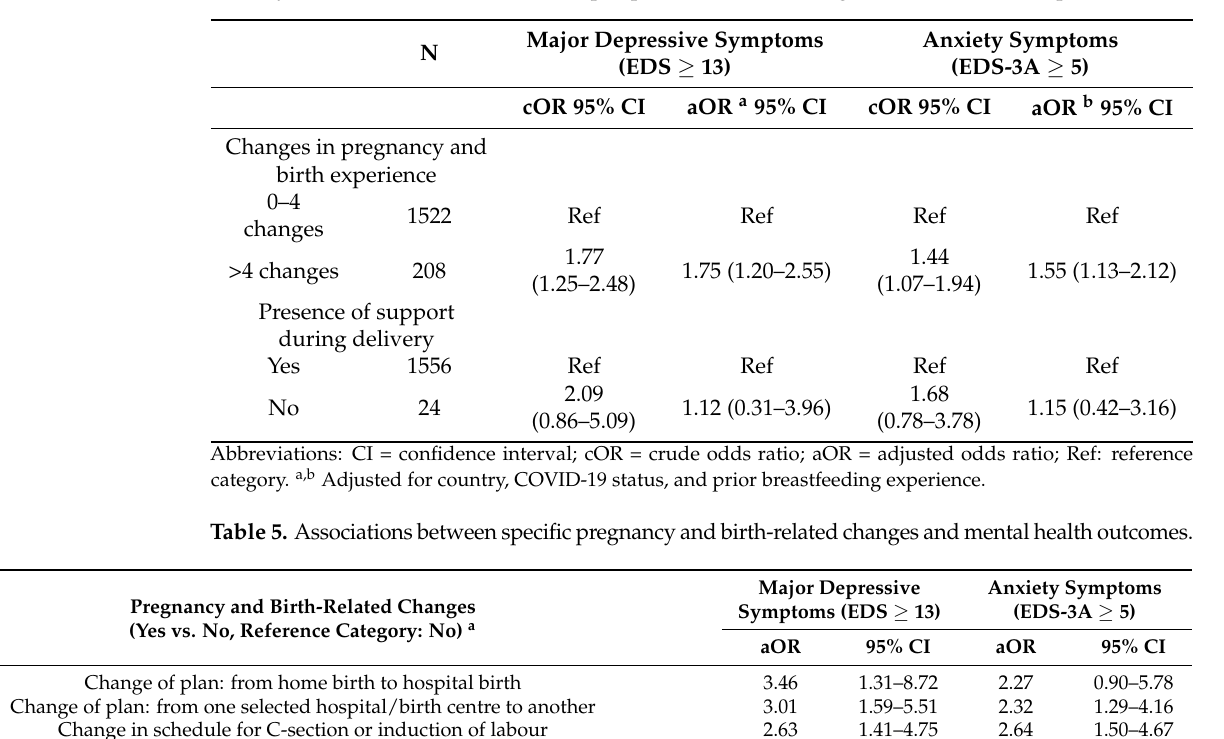
Table 4. Associations between (i) pregnancy- and birth-related changes and (ii) presence of support during delivery and mental health outcomes in postpartum women during the third wave of the pandemic. Major Depressive Symptoms Anxiety Symptoms N (EDS ≥ 13) (EDS-3A ≥ 5)